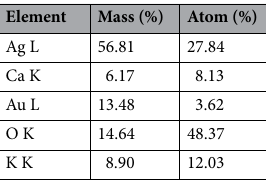
Table 1. EDX elemental analysis of